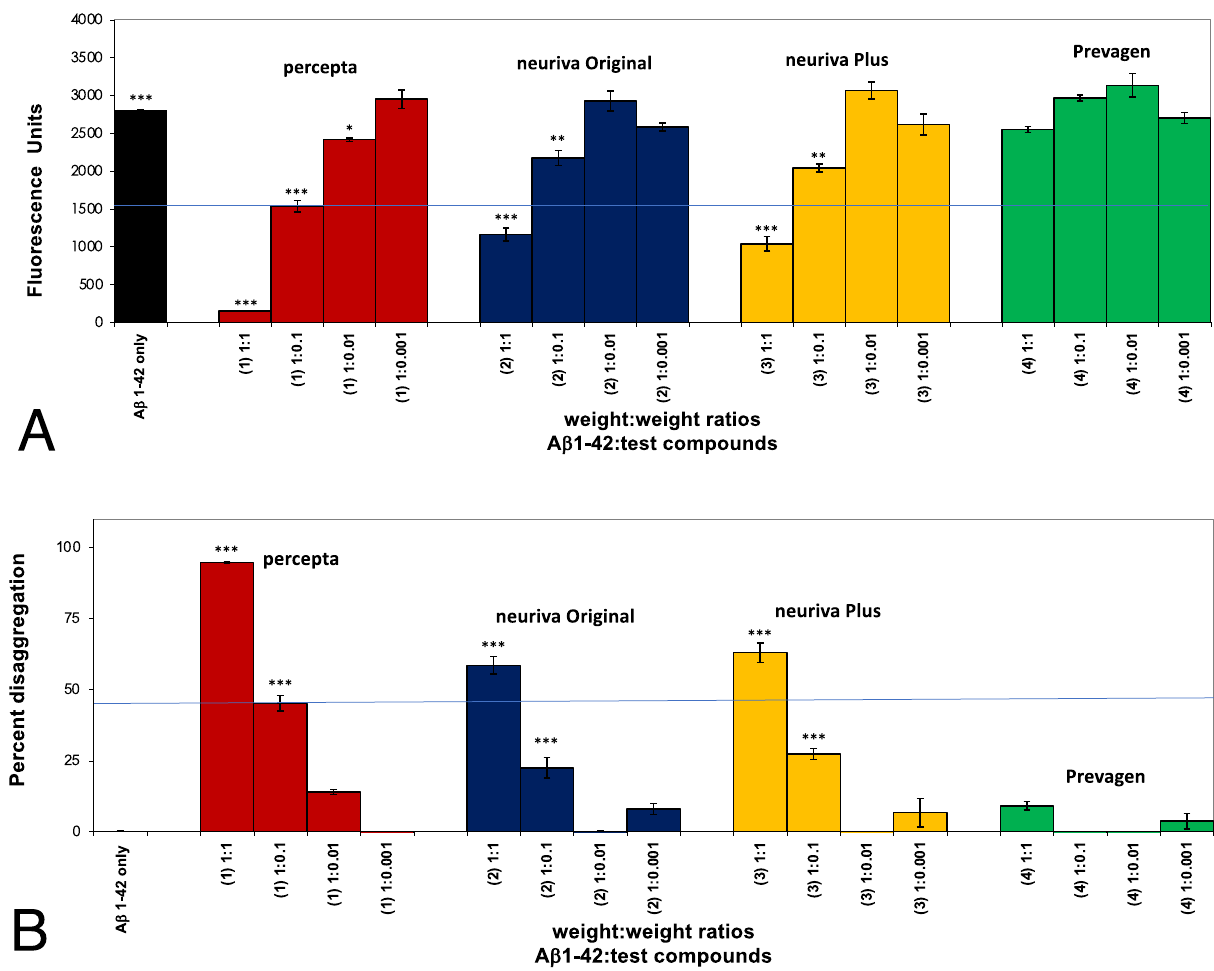
Figure 3. Percepta outperformed neuriva (Schiff Vitamins) for disaggregation/disruption of pre-formed Aβ 1–42 fibrils. ( A ) Percepta was tested in comparison to neuriva (neuriva Original and neuriva Plus) and Prevagen memory-support supplements on a wt/wt basis. Percepta was the most potent disrupter of Aβ 1–42 fibrils in comparison to neuriva (neuriva Original and neuriva Plus) and Prevagen on a wt/wt basis as quantitatively determined by Thioflavin T fluorometry. Aβ 1–42 fibrils demonstrate binding to Thioflavin T (indicator of fibril formation) and 2800 fluorescence units. Percepta demonstrated the most robust disaggregation/dissolution of pre-formed Aβ 1–42 fibrils. *p < 0.05, **p < 0.01, ***p < 0.001, by Student’s t-test. Bars represent mean ± SEM. ( B ) Comparison (on a wt/wt basis) of percepta to neuriva (Original and Plus) and Prevagen for % disaggregation of preformed Aβ 1–42 fibrils at 4 increasing dosages. Percepta had the most robust activity and reduced/ disaggregated Aβ 1–42 fibrils in a dose-dependent manner (light brown bars). At a Aβ:percepta wt:wt ratio of 1:0.1 (blue line across graph), percepta disaggregated Aβ 1–42 fibrils by 45.3%, whereas neuriva Original at that dose only disaggregated Aβ 1–42 fibrils by 25.4%, neuriva Plus only disaggregated Aβ 1–42 fibrils by 30.2%, and Prevagen did not work on amyloid plaque fibrils at all. *p < 0.05, **p < 0.01, ***p < 0.001, by Student’s t-test. Bars represent mean ±